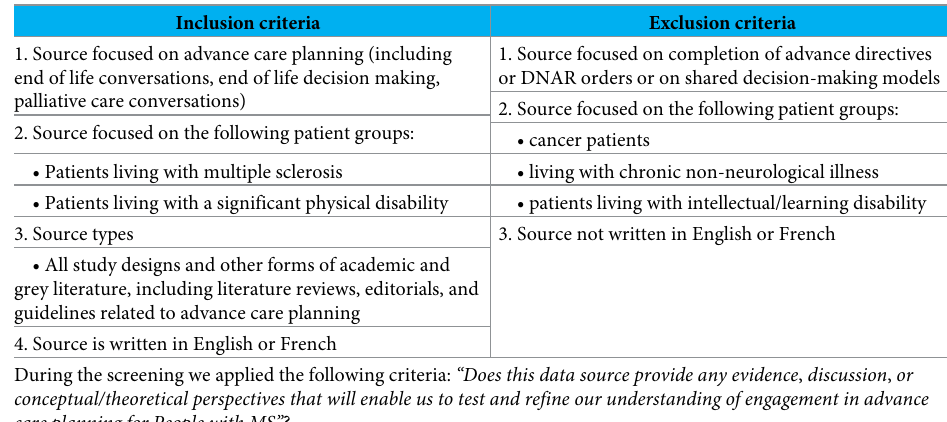
Table 4. Inclusion and exclusion